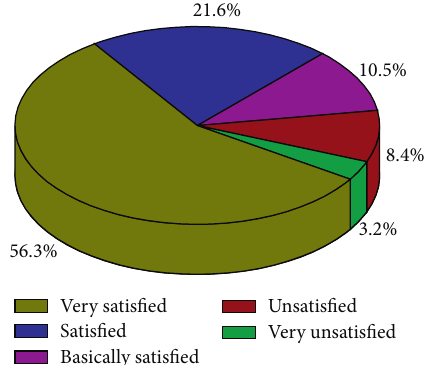
Figure 9: Satisfaction survey of the sculpture 3D model based on image